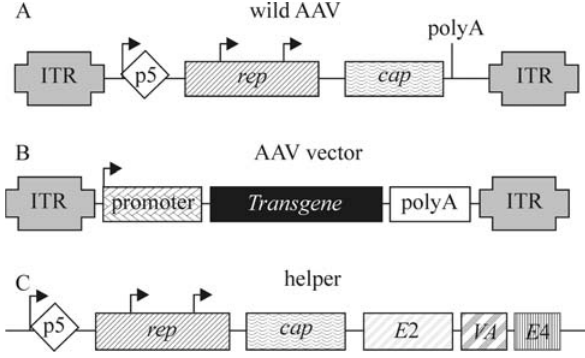
Figure 1 - AAV genetic structure. (A) Wild AAV; (B) AAV vector cas- sette, containing only the ITRs of the wild virus and the transgene and its promoter; (C) helper cassette, containing the AAV rep and cap genes re- quired for virus packaging and the Ad genes E2, VA and E4, required for virus replication (adapted from Pfeifer and Verma ,